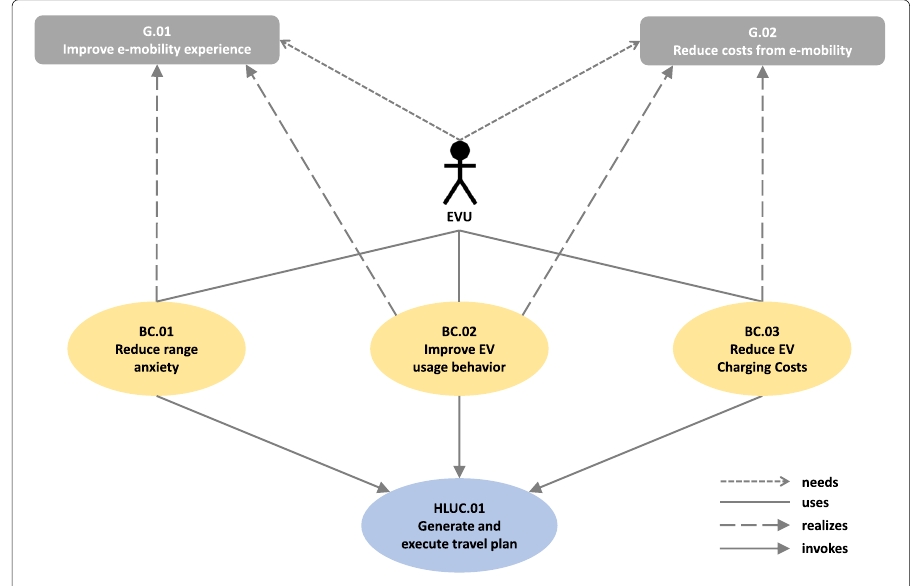
Fig. 11 Business analysis for the EV